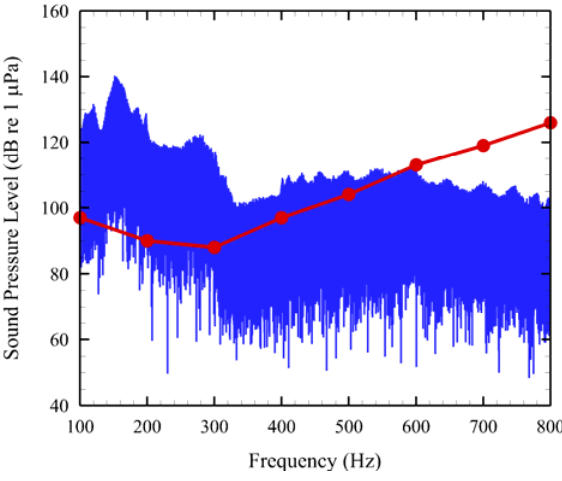
Figure 7. AEP derived audiogram for juvenile Chinook salmon overlaid on the sonogram of a noise